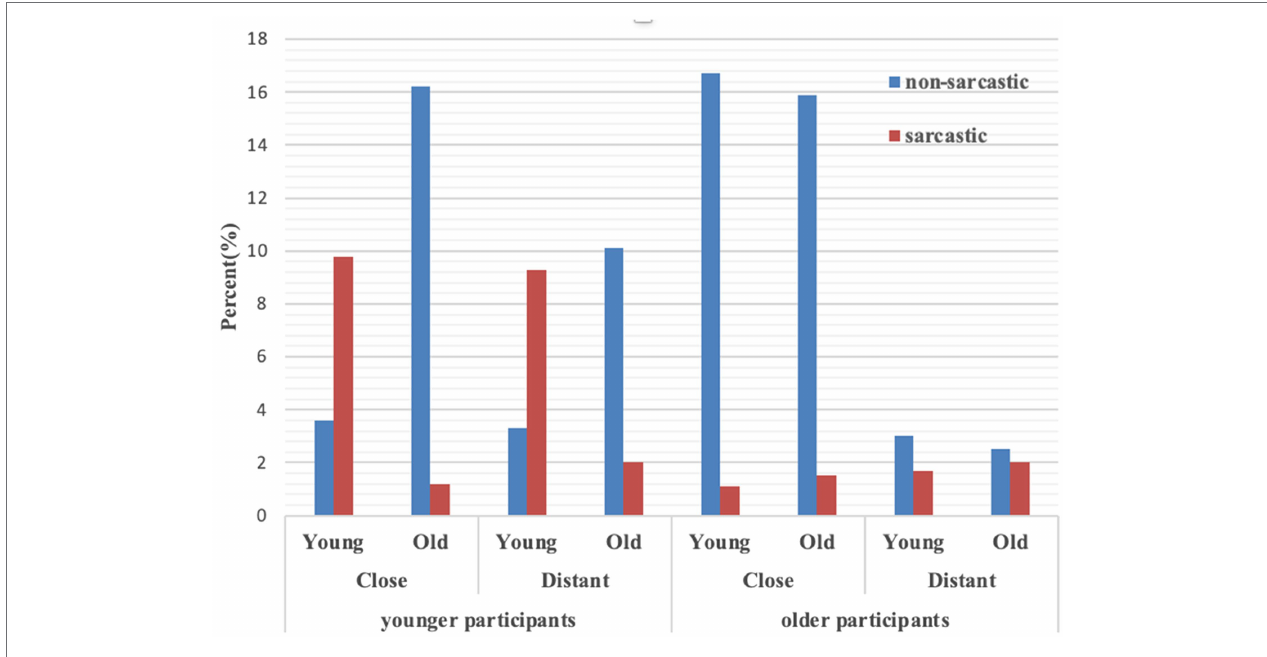
FIGURE 2 | Frequencies of sarcasm in Experiment